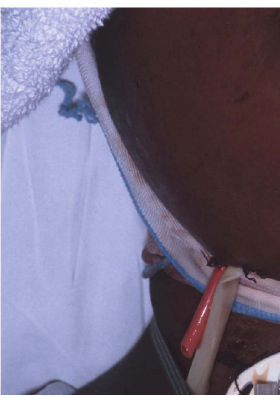
Figure 3: Patient postintervention. Note large number of